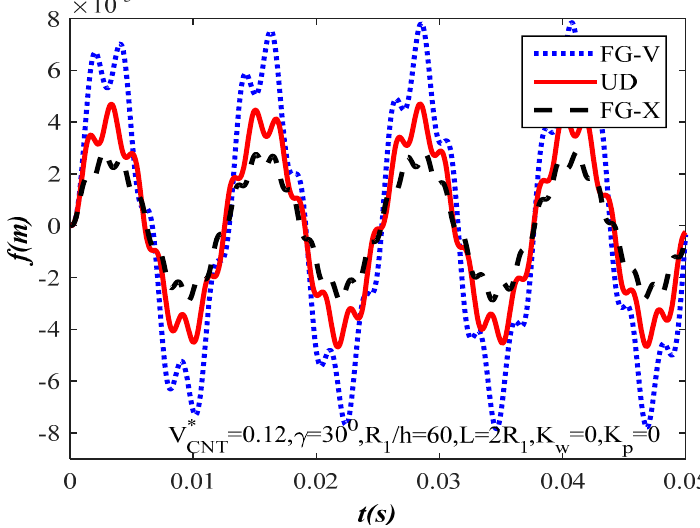
Figure 11. The dynamic response of CNTRC truncated conical shells with various types of CNT